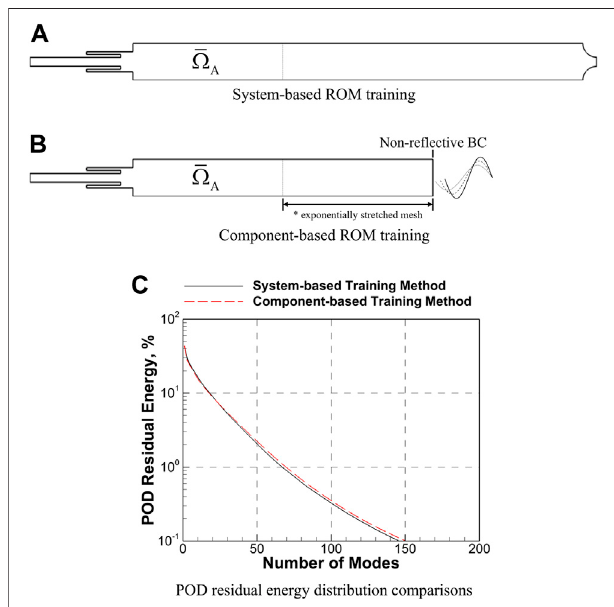
FIGURE 5 | ROM training strategies for the single-injector combustor, including (A) system-basedand (B) component-basedmethodsand (C) POD residual energy distribution comparisons the two training